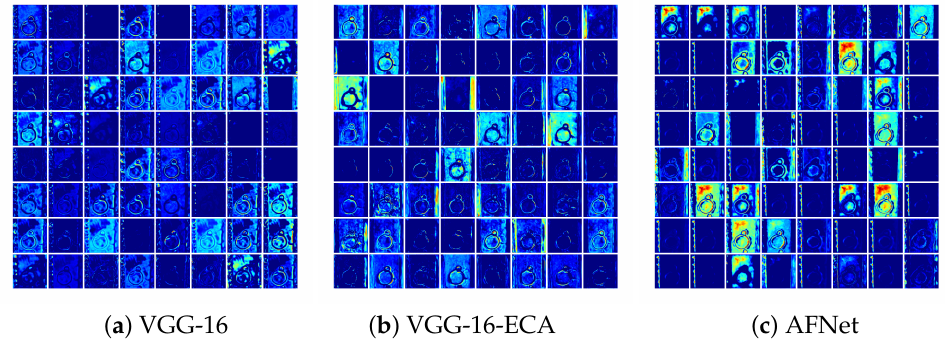
Figure 8. Comparison of partial output results of different network structures in decoder4. ( a ) Partial output feature maps with the basic model VGG-16, ( b ) partial output feature maps with VGG-16-ECA, ( c ) partial output feature maps with AFNet.